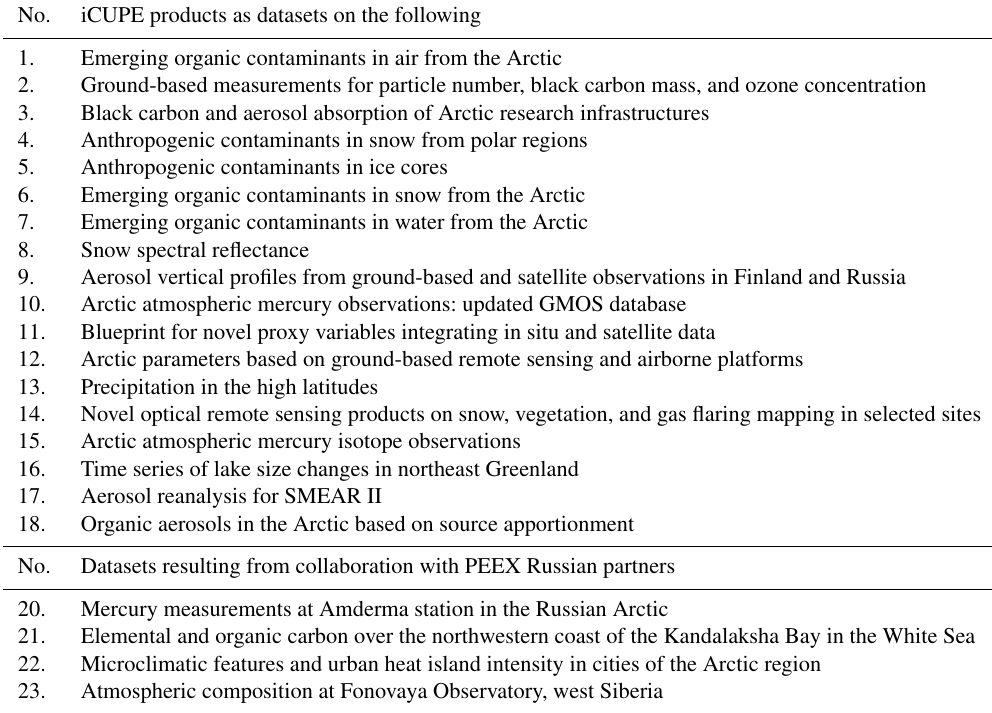
Table 1. The iCUPE products as datasets resulting from research activities of the project and collaboration with PEEX Russian partners. The first dataset was delivered in December 2018.